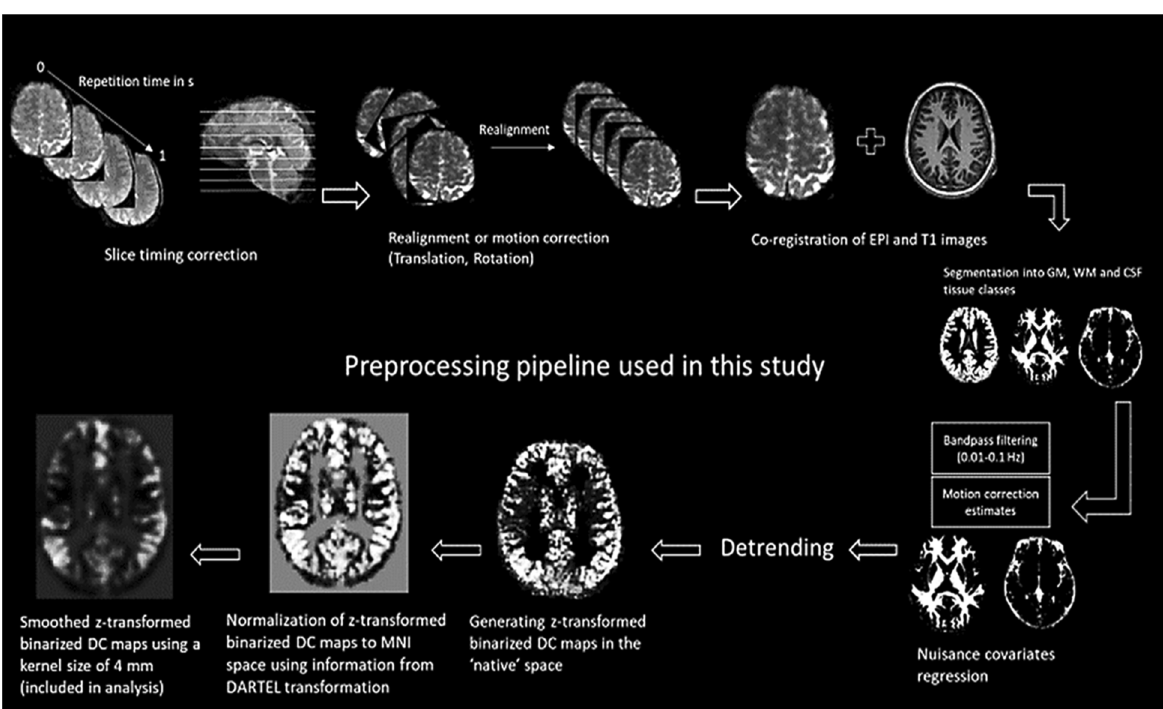
Fig. 3 Steps of preprocessing performed in this study. GM grey matter, WM white matter, EPI echo-planar imaging, DARTEL diffeomorphic anatomical registration through exponentiated lie algebra, DC degree